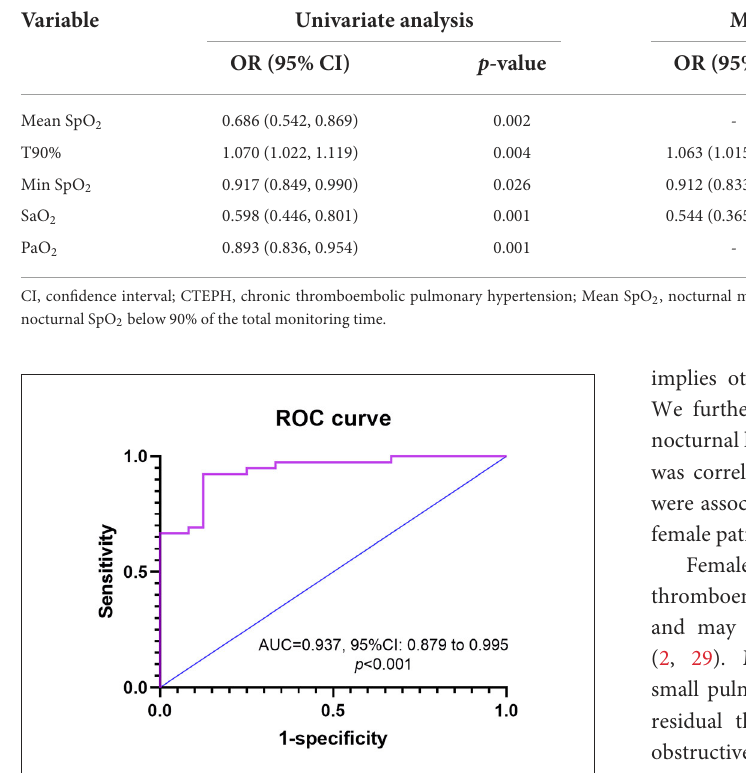
FIGURE4 The ROC curve is shown for HIS as determined by hypoxemia factors in predicting CTEPH for female patients. AUC, an area under ROC curve; CTEPH, chronic thromboembolic pulmonary hypertension; HIS, hypoxemia scoring index; ROC, receiver operating